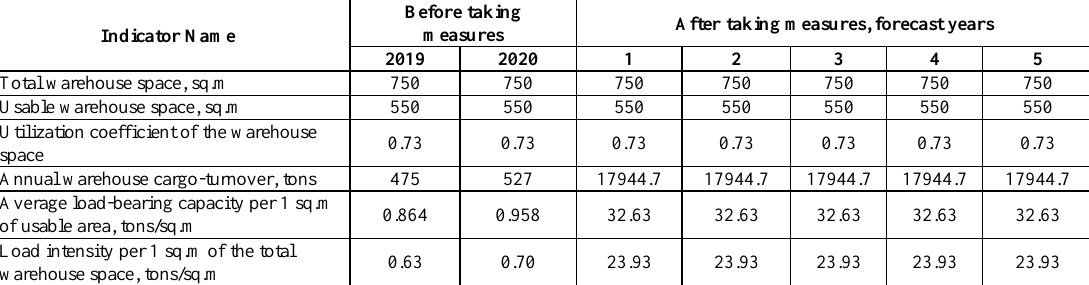
Table 7. Utilization performance indicators of the main warehouse space.